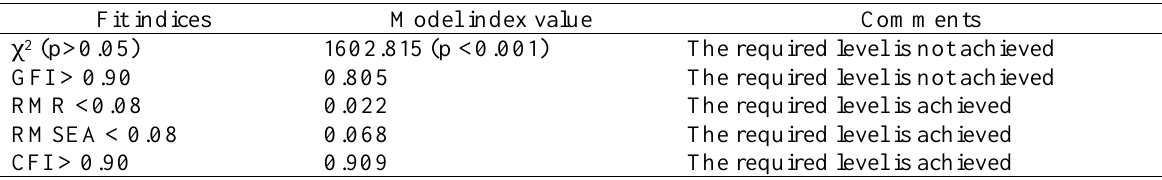
Estimation of Model Parameters and Model Fit Measurement Statistics Fit indices Model index value Comments χ 2 (p>0.05) 1602.815 (p <0.001) The required level is not achieved GFI > 0.90 0.805 The required level is not achieved RMR <0.08 0.022 The required level is achieved RMSEA < 0.08 0.068 The required level is achieved CFI > 0.90 0.909 The required level is achieved Note. GFI measure is affected by sample size. From “A simulation study to investigate the use of cutoff values for assessing model fit in covariance structure models,” by S. Sharma, S. Mukherjee, A. Kumar, and